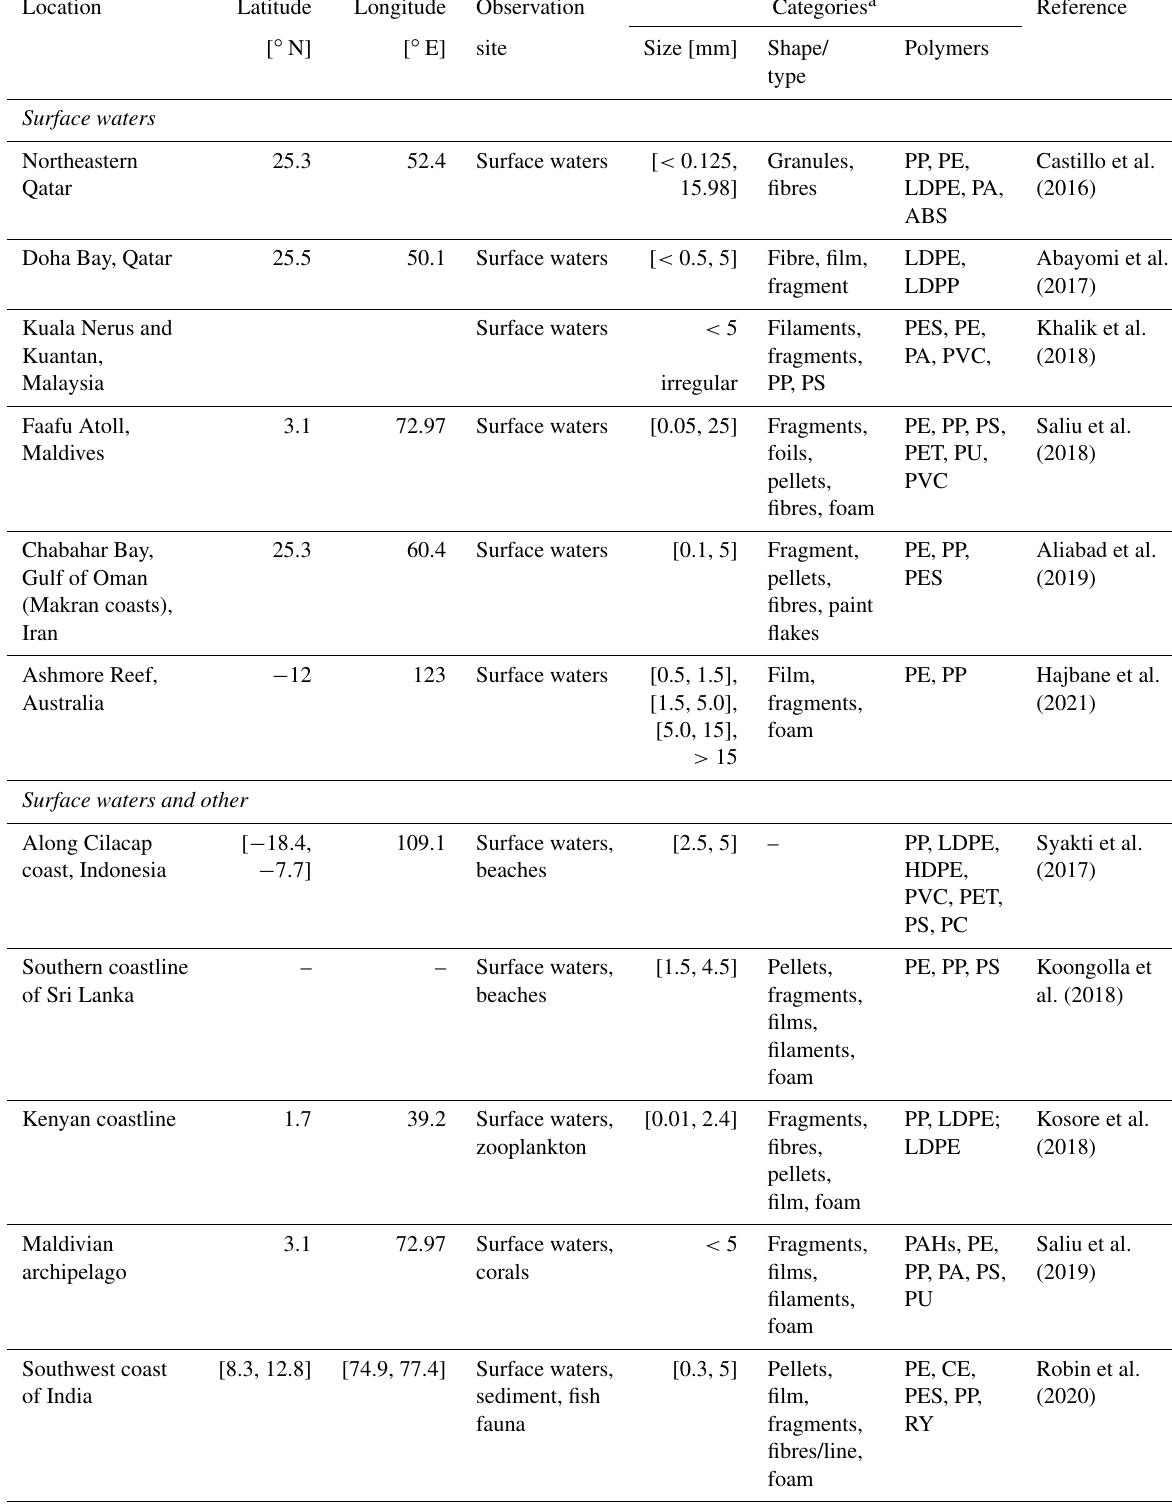
Table 1. Overview of plastic sampling studies performed in the Indian